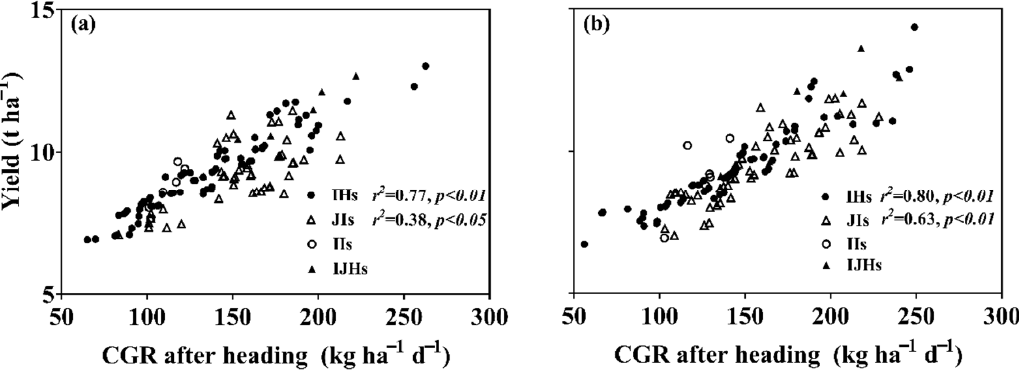
12 of 17 Figure 7. Boxplots of CGR during the total growth duration ( a , d ), CGR before heading ( b , e ), and